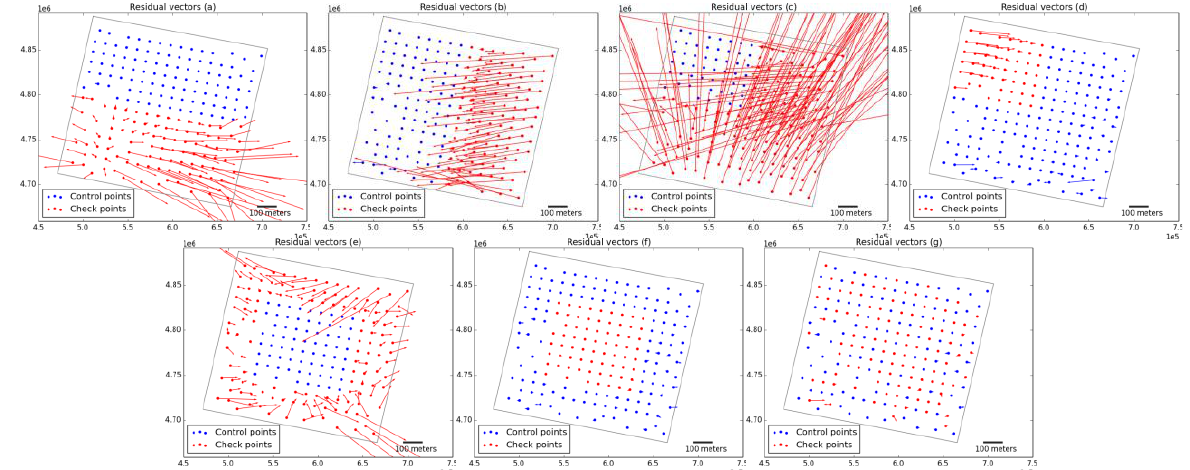
Figure 4. Residual vectors of polynomial model